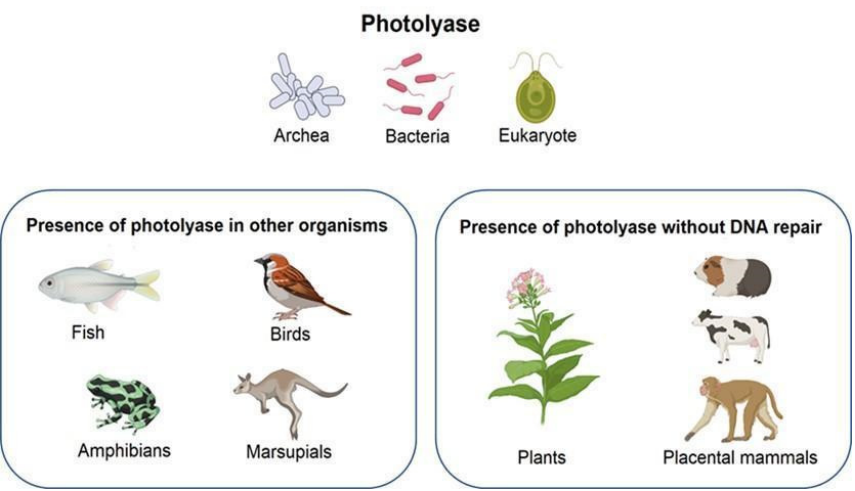
Figure 1. Presence of photolyase in different organisms. Due to evolution, some species lost the ability to repair DNA. Created with BioRender.com.